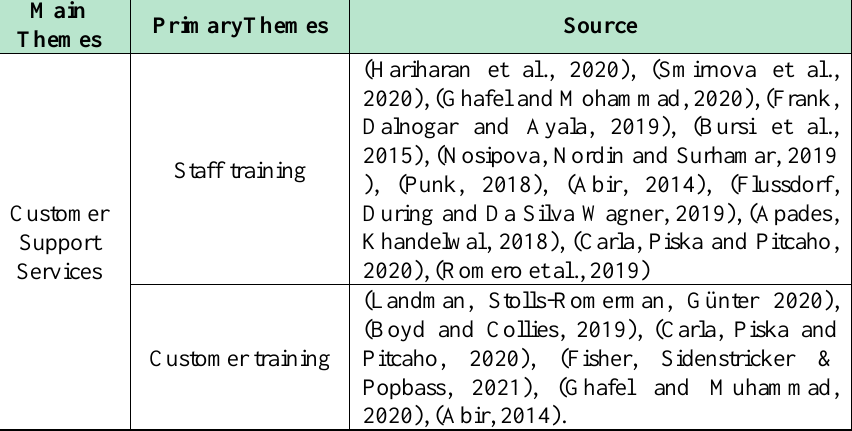
Table 6 - Customer Support